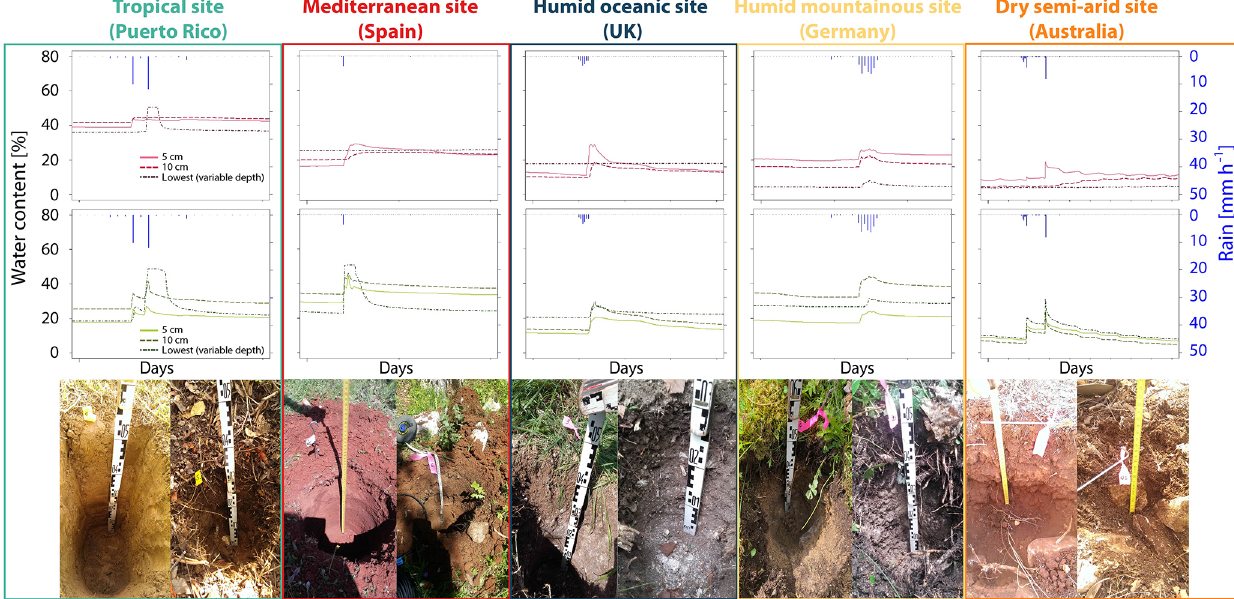
Figure 4. Examples of observed soil moisture dynamics at each site (example events for selected profiles). The top graphs with the red curves show the reaction of the probes at the grassland plots. The bottom graphs with the green curves show the reaction of the probes at the forest plots. The photos on the bottom row show the soil profiles of the respective plots (left is grassland plot, right is forest